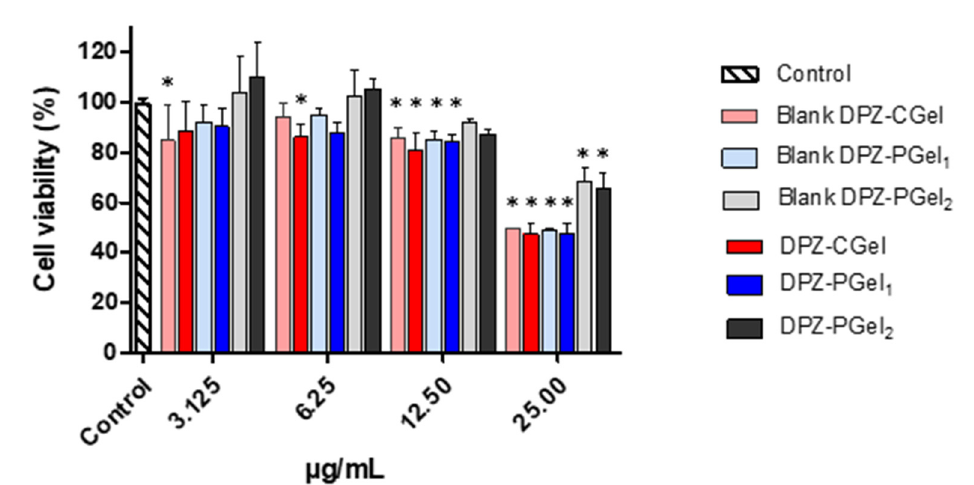
Figure 6. In vitro cytotoxicity of donepezil (DPZ) formulations. Although statistical differences to the control were observed at different concentrations, cells were viable up to 12.5 µg/mL. * Statistical significance set at p < 0.05.